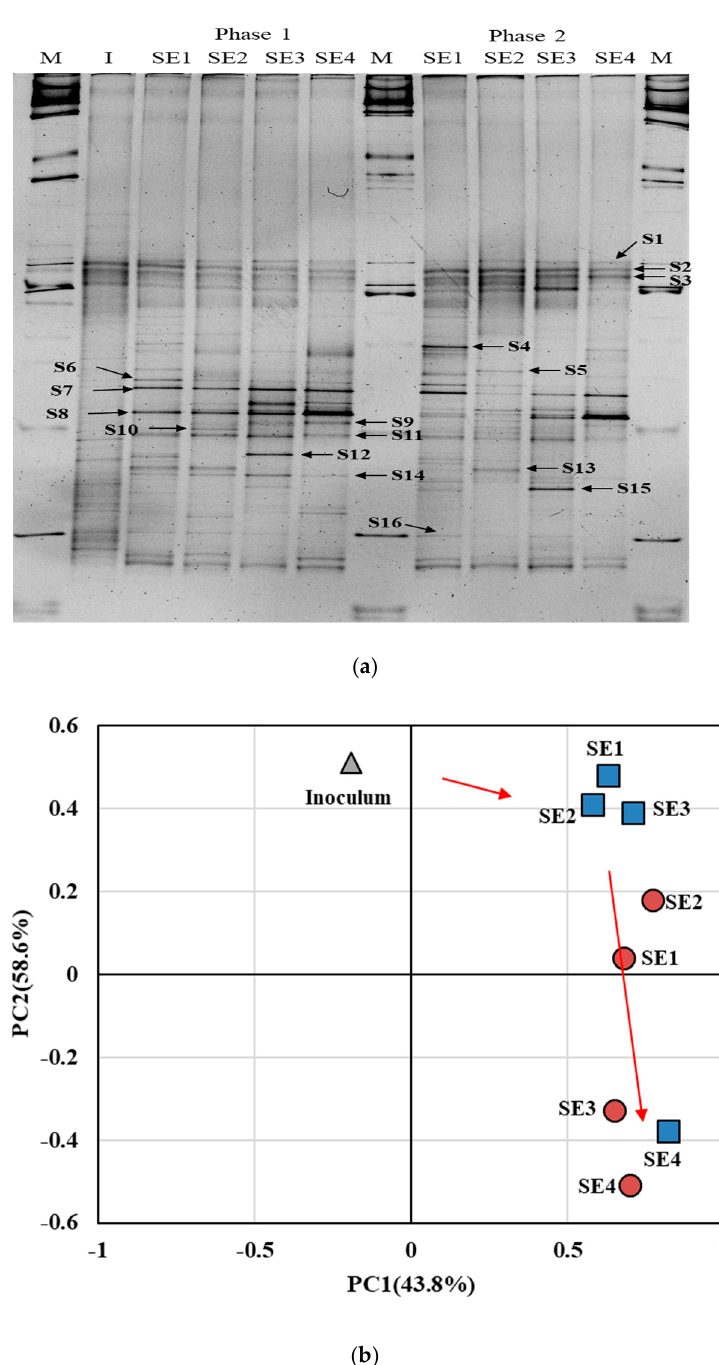
Figure 5. Denaturing gradient gel electrophoresis (DGGE) profiles ( a ) and PCA based on DGGE profiles ( b ) of EBR treating synthetic wastewater (WW) at phases 1 (square) and 2 (circle); The red arrow indicates the shift direction of the microbial community.